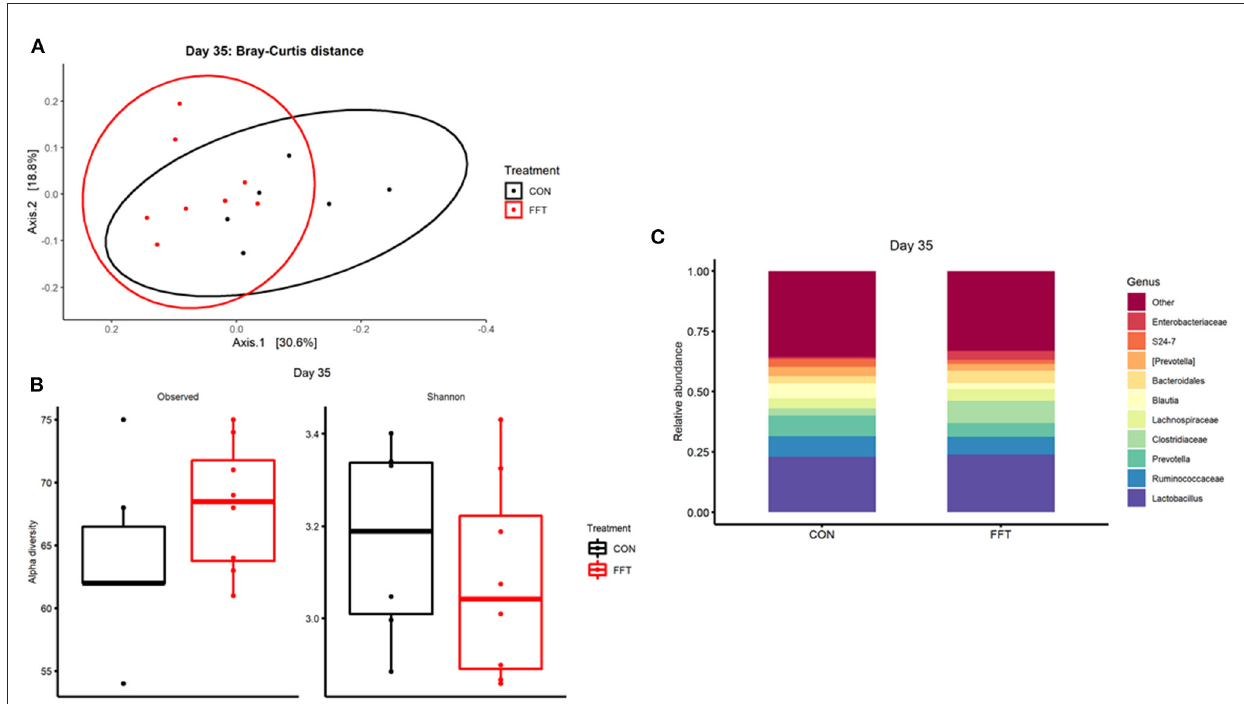
FIGURE4 Gut microbiota composition after treatment with either fecal filtrate transplantation (FFT) or sterile saline (CON). (A) Unweighted metrics-based measure of beta diversity on day 35. (B) Observed and Shannon index as a measure of alpha diversity on day 35. (C) Relative bacterial abundances from colon luminal content presented as stacked bar graphs at genus levels on day